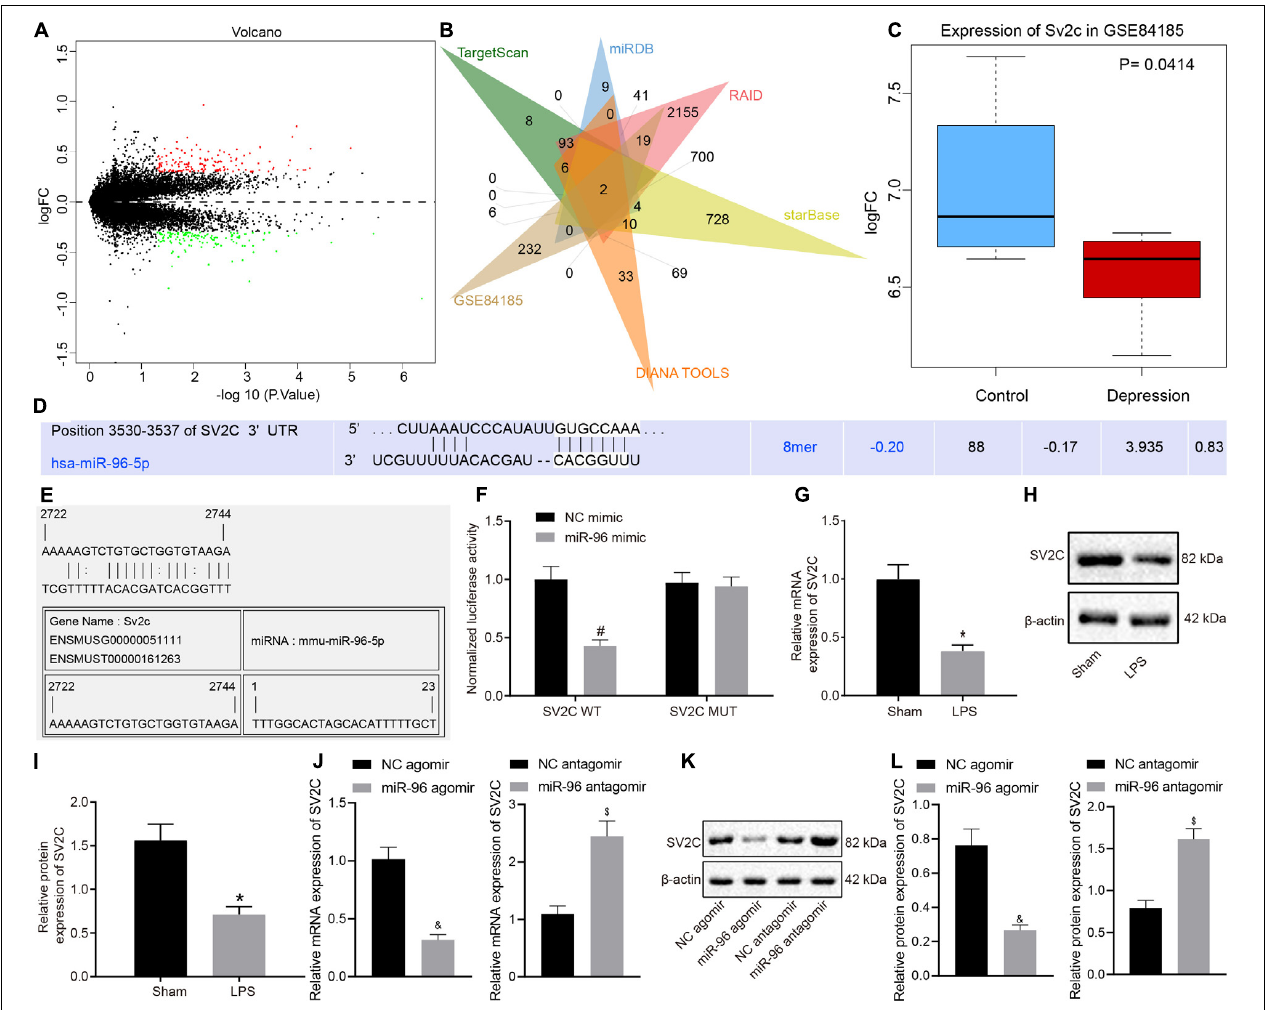
FIGURE 3 | SV2C is targeted by miR-96. (A) Volcano map for the anterior cingulate cortex of gene expression dataset GSE84185, where red dots indicate significantly upregulated genes, green dots indicate significantly downregulated genes, and black dots indicate genes with no significant difference; (B) Venn map of miR-96 downstream target genes predicted by TargetScan, miRDB, RAID, starBase, and DIANA TOOLS and differentially expressed genes in anterior cingulate cortex of expression dataset GSE84185, the intersection genes are WDR82 and SV2C. (C) Expression of SV2C in normal tissues and depression model in GSE84185. (D) TargetScan prediction of the binding sites between miR-96 and SV2C. (E) RNA22 website predicts binding site of miR-96 with SV2C. (F) Validation targeting relationship between miR-96 and SV2C by dual-luciferase report gene assay [ N = 3, F (1,8) = 30.06]. (G) RT-qPCR detection of SV2C mRNA expression in mice after LPS induction [ N = 10, t (11.76) = 14.56]. (H,I) Western blot analysis of SV2C protein expression in mice after LPS induction [ N = 10, t (12.9) = 13]. (J) RT-qPCR detection of SV2C mRNA expression in LPS-treated mice after miR-96 alteration [ N = 10, t agomir (12.31) = 19.87, t antagomir (18) = 14.46]. (K,L) , Western blot analysis of SV2C protein expression in LPS-treated mice after miR-96 alteration [ N = 10, t agomir (10.99) = 15.57, t antagomir (18) = 16.78]. * p < 0.05 vs. sham-operated mice, # p < 0.05 vs. NC mimic, & p < 0.05 vs. LPS-treated mice injected with NC agomir, $ p < 0.05 vs. LPS-treated mice injected with NC antagomir. Measurement data were expressed as mean ± standard deviation. When data were in compliance with normal distribution and homogeneity of variance, unmatched data between two groups were compared using an unpaired t -test. Comparisons among multiple groups in (E) were conducted by two-way ANOVA, followed by Bonferroni’s post hoc test. Cell experiment was independently repeated three